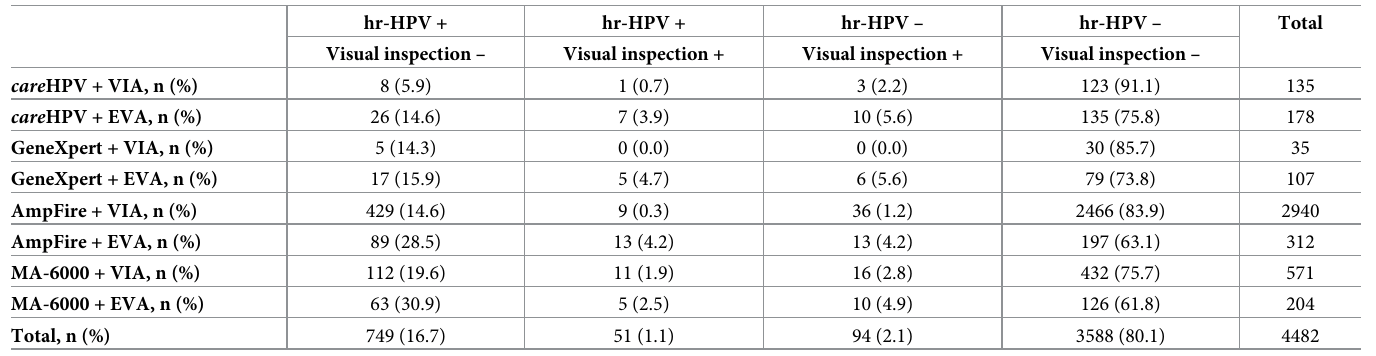
Table 2. Distributions of results of concurrent hr-HPV testing and visual inspection screening stratified by method. hr-HPV + hr-HPV + hr-HPV – hr-HPV – Total Visual inspection – Visual inspection + Visual inspection + Visual inspection